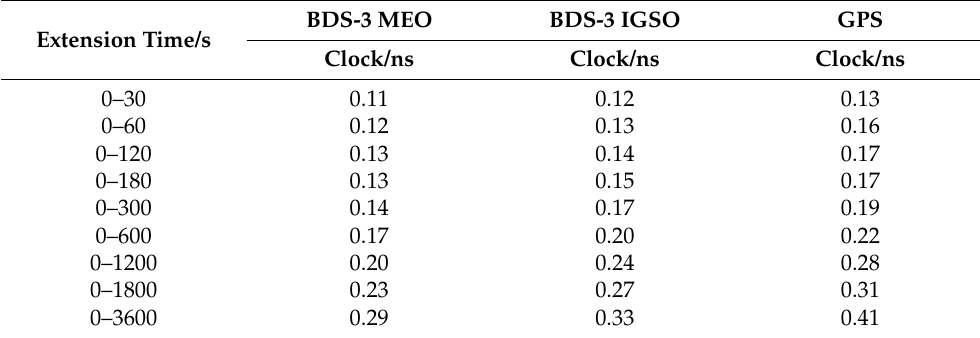
Table 3. Mean STD of the PPP-B2b clock products recovered with extension corrections using the GBM clock products as a reference during DOY 192–198 in 2022.